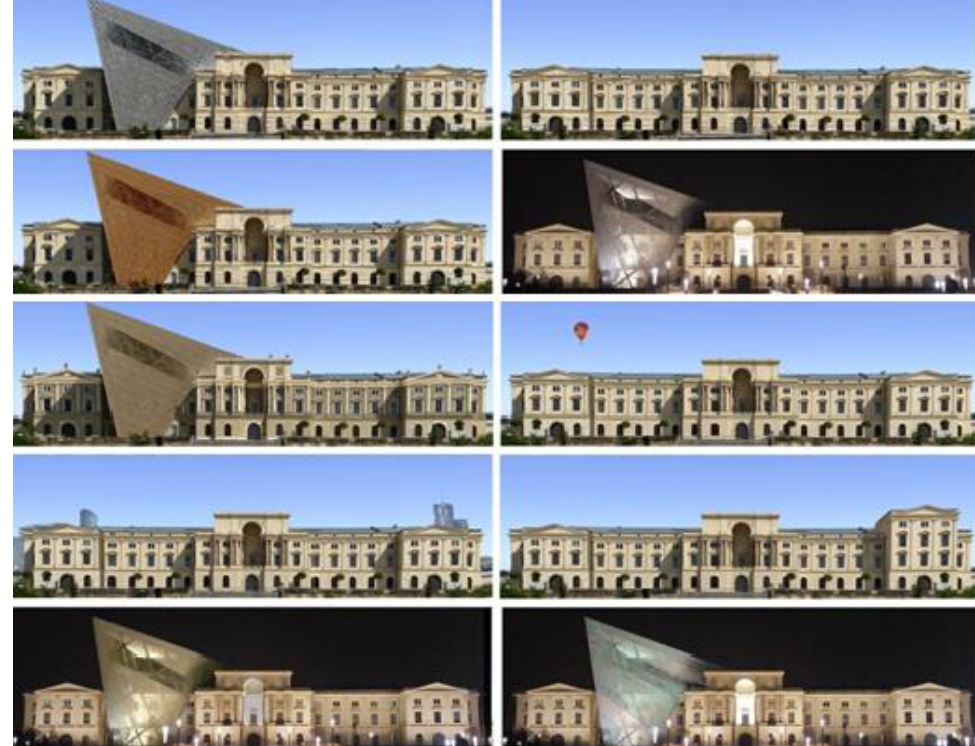
Figure 3. Variant studies on the perception of different architectural concepts, including conscious design of illumination, in the scale of a single building seen from the outside [57,58]. In the end, only the first four visualizations were used in eye-tracking research conducted in 2017. The full compilation of these images indicate a wide range of problems and ideas that caught the attention of the students.